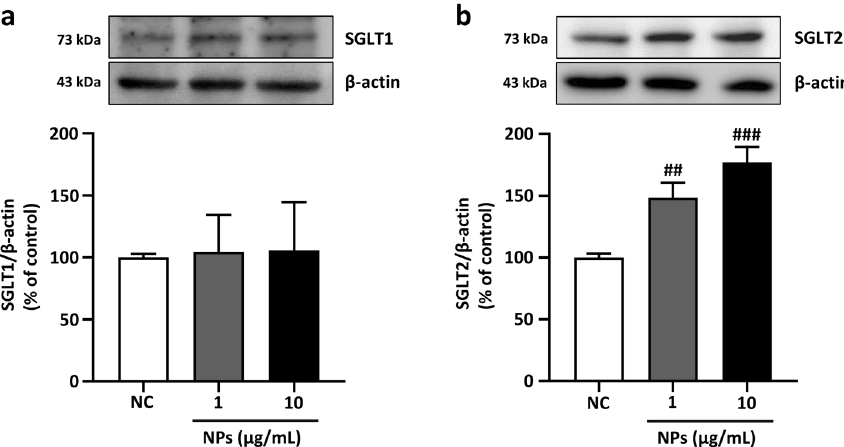
Figure 1. NPs exposure increases SGLT2 expression in PCAECs. PCAECs were incubated in the presence of different NPs concentrations (1 and 10 μg/mL) for 24 h and level of SGLT1 and SGLT2 expression were determined by western blot. ( a–b ) Representative immunoblots of SGLT1 and SGLT2 with their respective cumulative data. Data are the mean ± SEM (n = 3–5). ## p < 0.01, ### p < 0.001 versus NC: negative control (complete